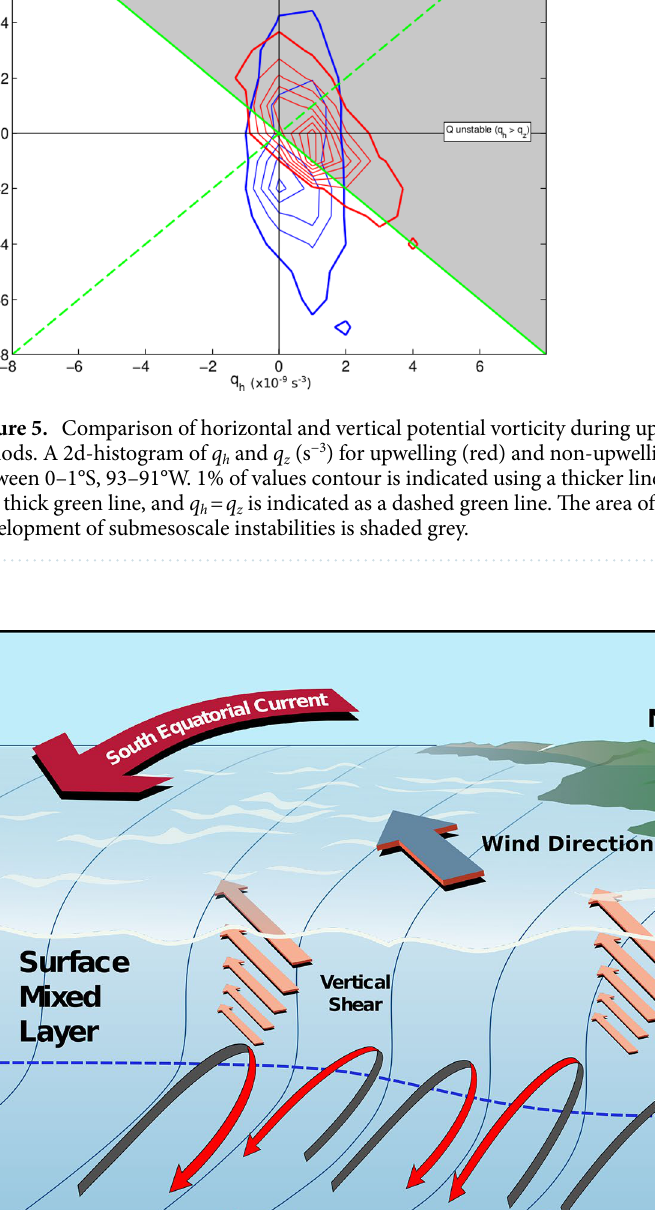
density fronts around the western flank of the archipelago that enables wind forcing to preferentially trigger the instabilities in that area, relative to a wider region of the eastern Pacific forced by similar winds 22 . To assess the physical underpinning of the persistent lateral density gradients to the west of the islands, we conduct additional model simulations in which we alter the archipelago’s position and/or geometry, as well as aspects of the wind forcing (see Suppl. Info. and Figs. S4 and S5). Analysis of this simulation suite reveals that the density fronts are